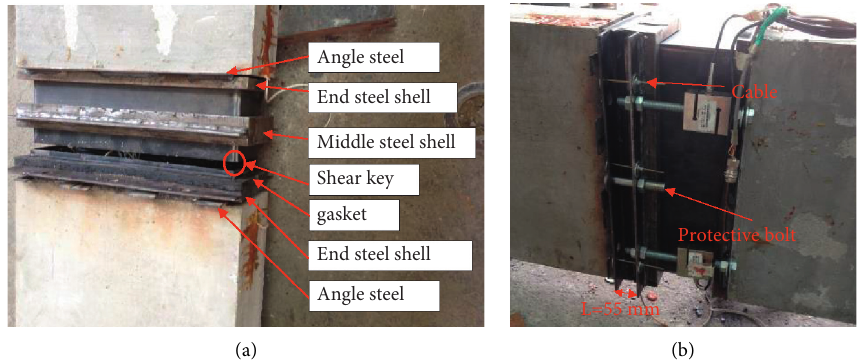
Figure 5: Joint of model. (a) Details of joint component. (b) Prestressed cables.